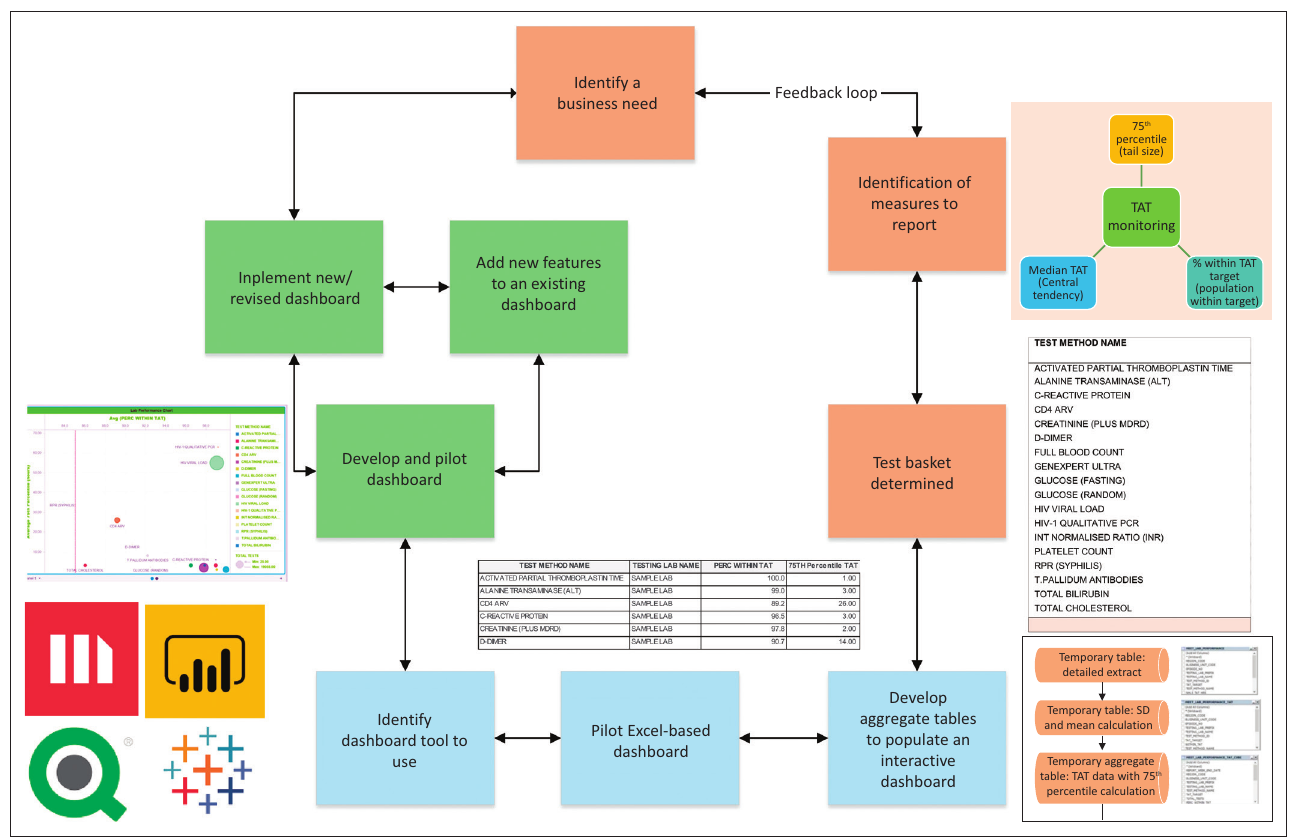
FIGURE 1: Flowchart depicting all steps required to develop a turn-around time dashboard, South Africa, 2018.